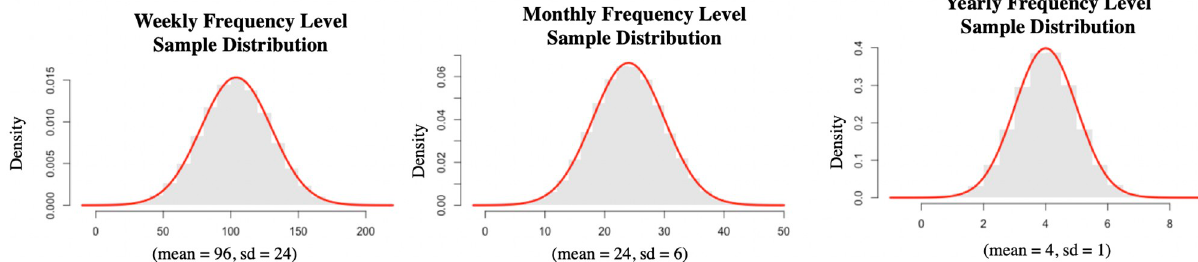
Fig 4. Histograms of generated samples at each frequency